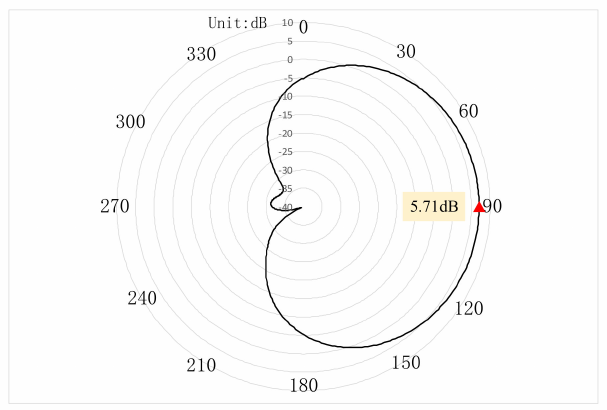
Figure 10. Improved transmitting antenna pattern.